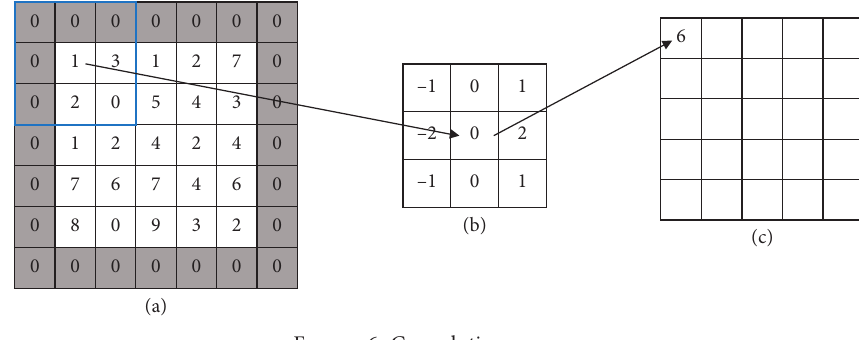
Figure 6: Convolution process.